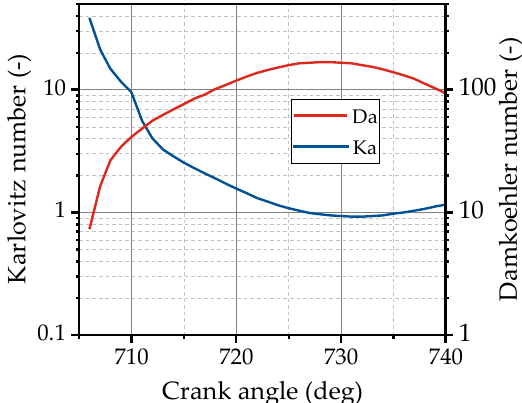
Figure 14. Karlovitz and Damkoehler number as functions of the crank angle.